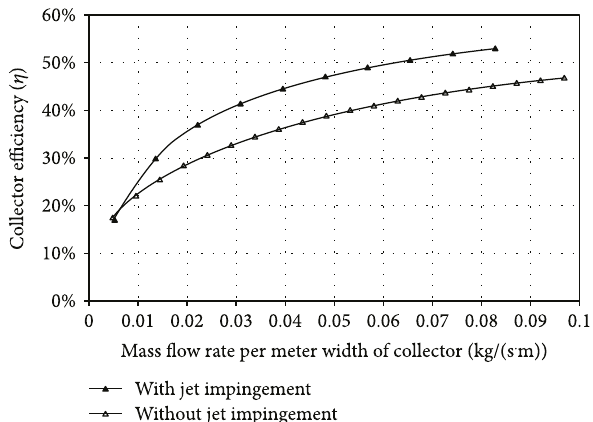
Figure 6: E ffi ciency at typical conditions of the collector with and without jet impingement